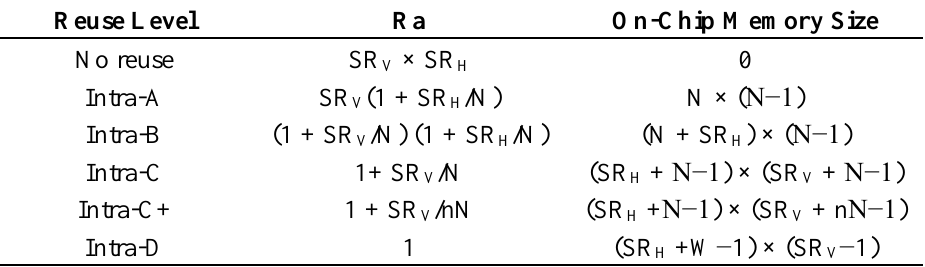
Table 3. Intra-frame Data Reuse